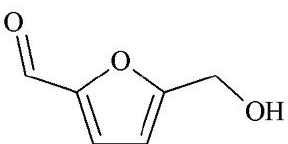
Figure 1. Chemical structure of HMF.